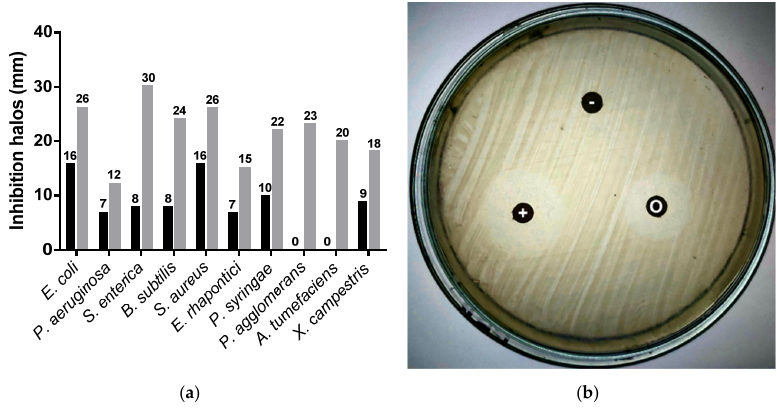
Figure 2. ( a ) Inhibitory activity (mm) of O. vulgare essential oil against pathogens and five phytopathogenic bacteria. ( ■ ) oregano; ( ■ ) kanamycin positive control. ( b ) Paper disk diffusion assay of oregano essential oil against Escherichia coli . Disk O: oregano oil; disk + : kanamycin positive control; disk − : ethanol negative control. Table 4. shows the inhibitory and bactericidal effects of oregano oil, tested on five species of bacteria of clinical importance ( Escherichia coli , Pseudomonas aeruginosa , Salmonella enterica , Bacillus subtilis , and Staphylococcus aureus ) and five species of plant ‐ pathogenic bacteria ( Erwinia rhapontici , Pseudomonas syringae , Pantoea agglomerans , Agrobacterium tumefaciens , and Xanthomonas campestris ). The different bacterial species tested showed varying susceptibility to the effects of the essential oil, which was expected since bacterial susceptibility to antimicrobial compounds is variable even at the strain level. This variation is due to specific differences in the composition of the different macromolecules and structures that these microorganisms possess. From Table 4, it can be observed that almost all microorganisms were susceptible to the action of oregano essential oil, with a variation in the MIC values from 0.04% v/v to 0.63% v/v and MBC values from 0.08% v/v to 1.25% v/v . P. agglomerans and A. tumefaciens showed resistance to the antimicrobial activity, and P. aeruginosa presented the highest resistance (0.63% v/v MIC and 1.25% v/v MBC). Kanamycin (50 μ g) was used as a positive control of bacterial inhibition. E. rhapontici (0.04% v/v MIC and 0.08% v/v MBC) and X. campestris (0.08% v/v MIC and 0.08% v/v MBC) were the most susceptible phytopathogenic bacteria to oregano oil, with the lowest concentrations necessary to inhibit bacterial growth. These results could indicate a potential use of this essential oil in agriculture and agribusiness [43]. On the other hand, among the bacteria of clinical importance, S. aureus and S. enterica (0.08% v/v MIC and 0.08% v/v MBC) were the most susceptible to oregano oil. These results represent a promising strategy for controlling common foodborne pathogens. Table 4. Antibacterial activity of Origanum vulgare essential oil from Putre, Chile. Bacteria